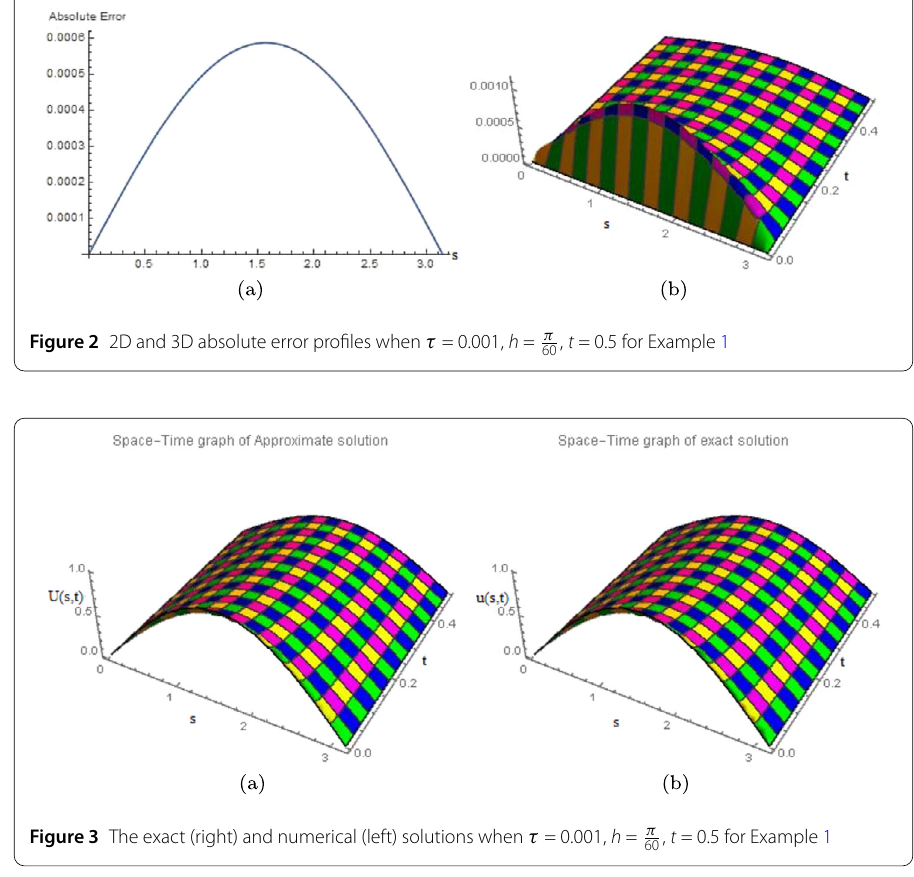
Table 1 Comparison of error norms when γ = 0.8, h = π